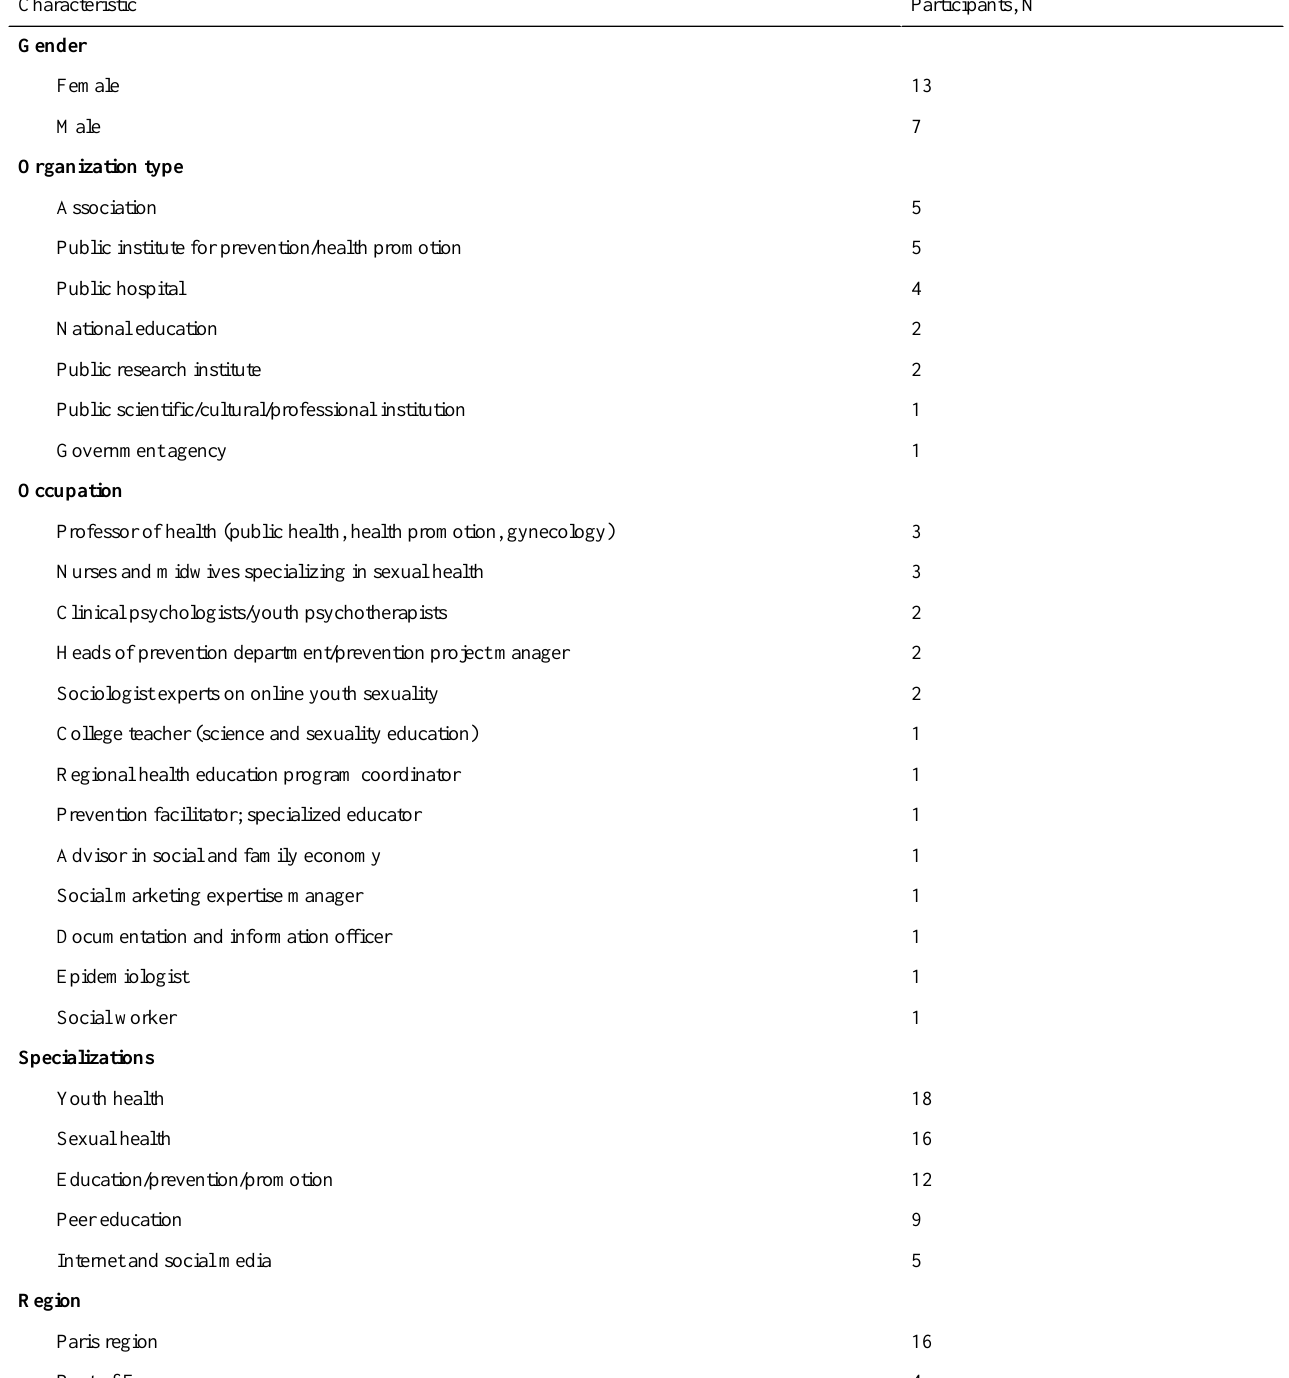
Table 1. Expert characteristics